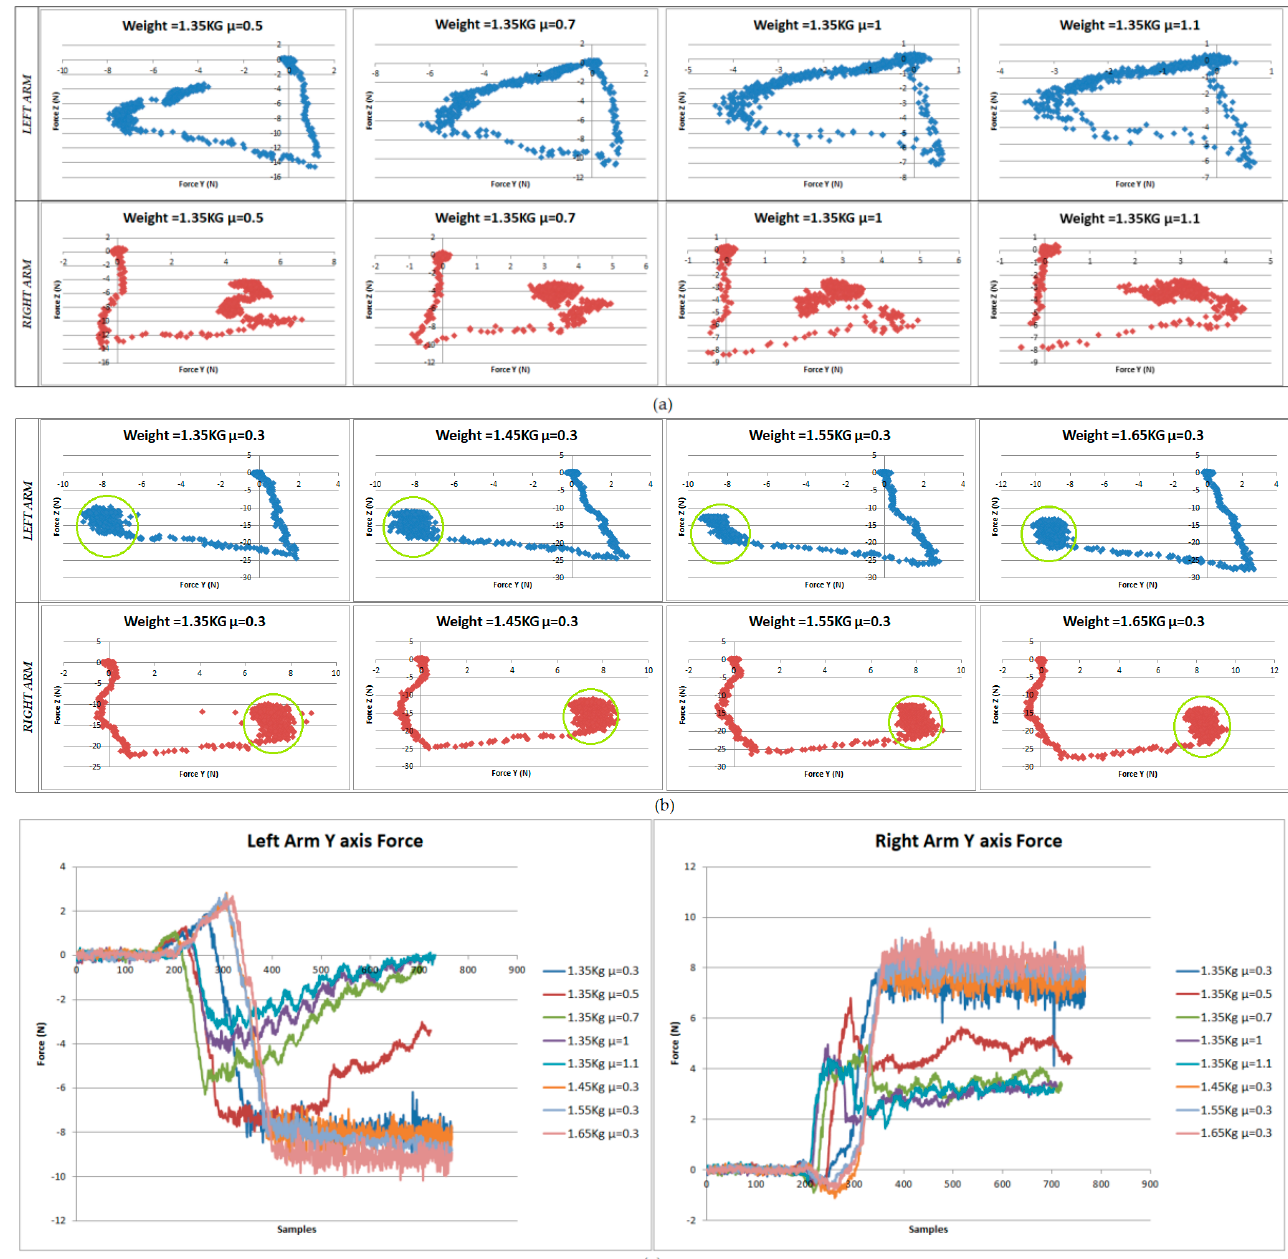
Figure 12. ( a ) Relation between the force in the Z and Y axis for the experiments where the lifting action failed. ( b ) Relation between the force in the Z and Y axis for the successful experiments. ( c ) Friction forces of the end effectors against the slippage of the box in the Y axis.